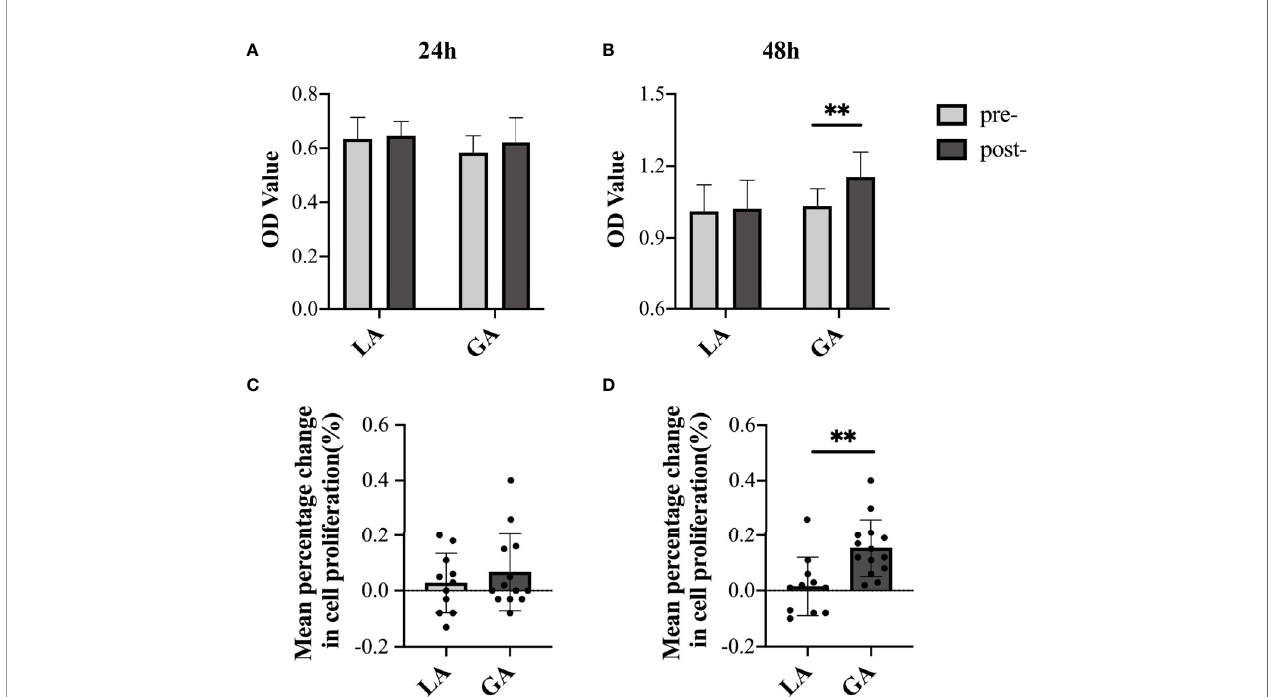
FIGURE 4 | Serum from RFA patients receiving GA facilitated cell proliferation of HepG2 cells after long-term, but not short-term, exposure. (A) CCK-8 assay OD values (culture time = 24h); (B) CCK-8 assay OD values (culture time = 48h); (C) mean percentage change from post- to preoperative OD value (culture time = 24h);